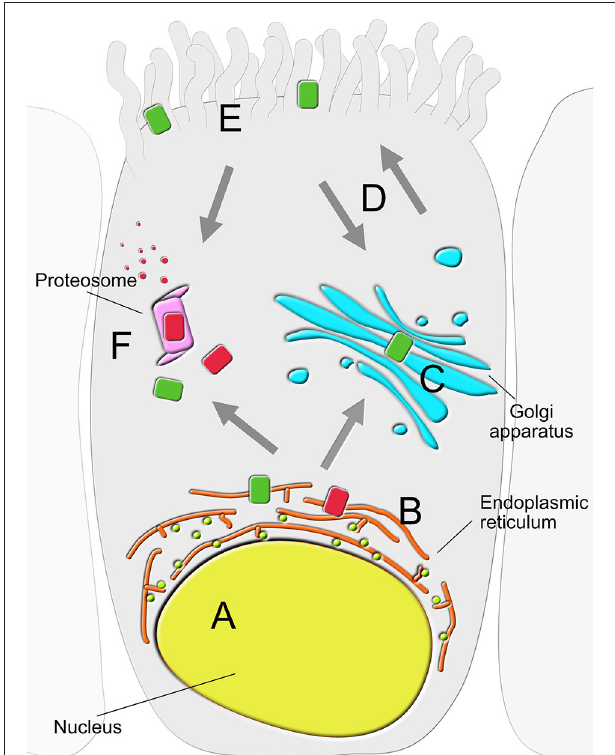
FIGURE 1 | Location of CFTR-interacting proteins in the secretory epithelial cell. Physical and functional interactors of wild type (green) and mutant (red) CFTR can be largely grouped into six clusters based on the primary location where the interaction takes place; (A) nucleus, (B) endoplasmic reticulum (ER), (C) Golgi apparatus, (D) trafficking vesicles, (E) plasma membrane (PM) and (F)